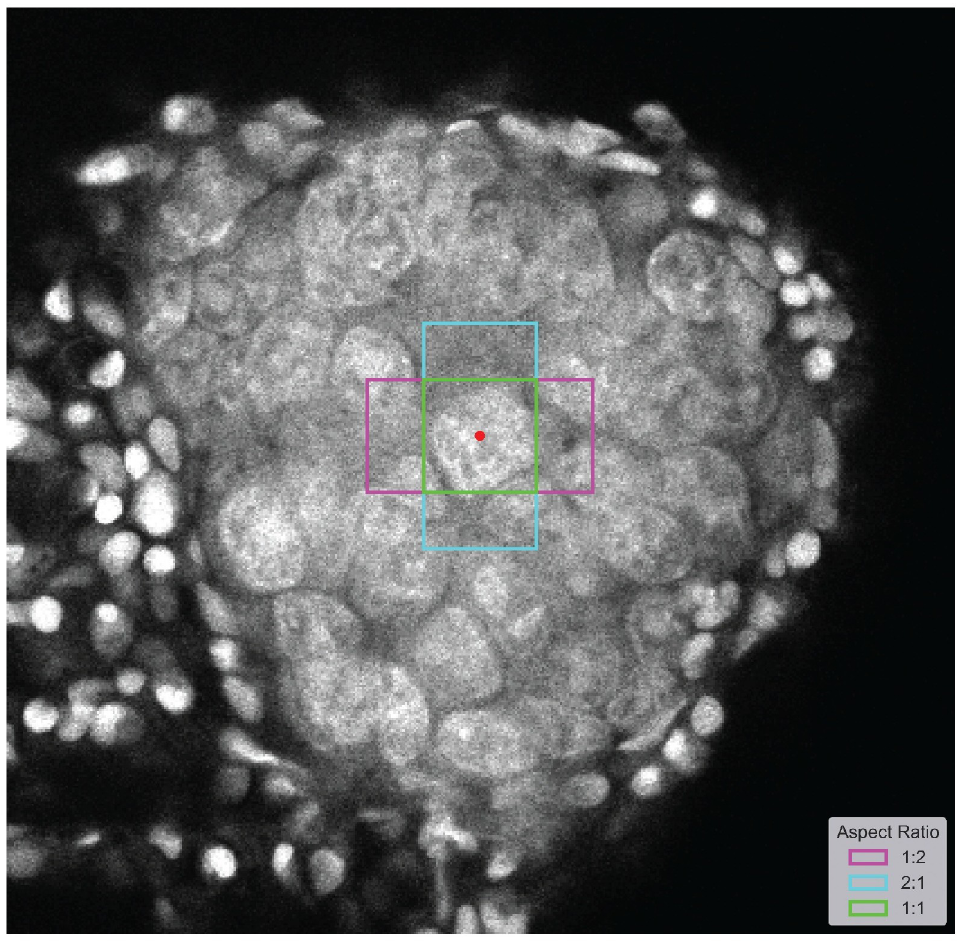
Fig 4. Example of possible aspect ratios, taking into account the ratio distribution. The magenta shape corresponds to a 1:2 aspect ratio, the blue corresponds to a 2:1 aspect ratio, and the green corresponds to a square. The red dot is the anchor.